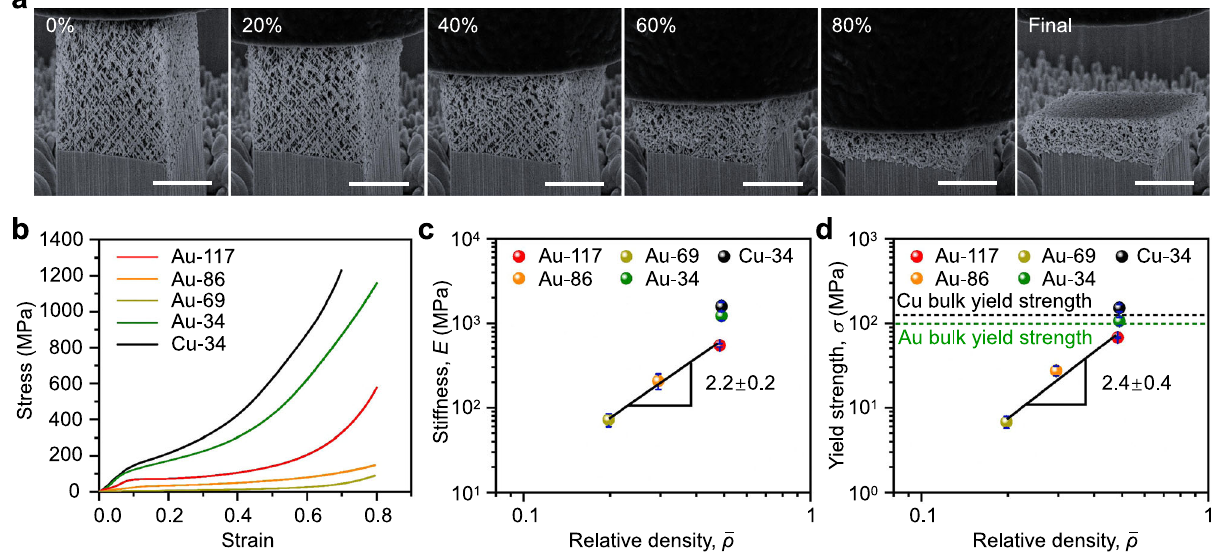
Fig. 3 | Compression tests on the gold and copper quasi-BCC nanolattices. a SEM snapshots of the deformation process of the sample Au-69. b Stress – strain curvesofthegoldandcopperquasi-BCCnanolatticesofthesamplesAu-117,Au-86, Au-69, Au-34, Cu-34, respectively. c Compressive stiffness versus relative density